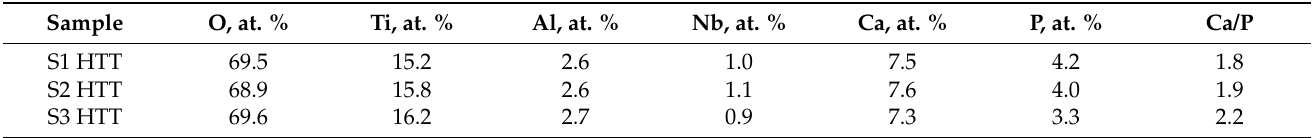
Table 4. EDS elemental analysis data for samples S1 HTT–S3 HTT.